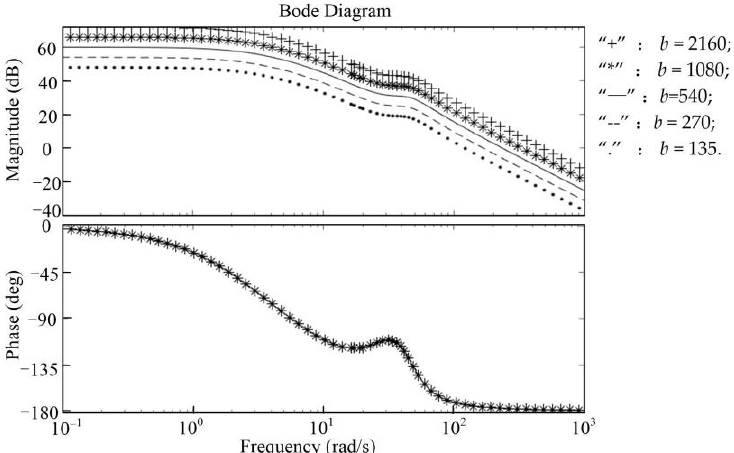
Figure 9. Bode diagram of the external disturbance to the system output transfer function when b changes.